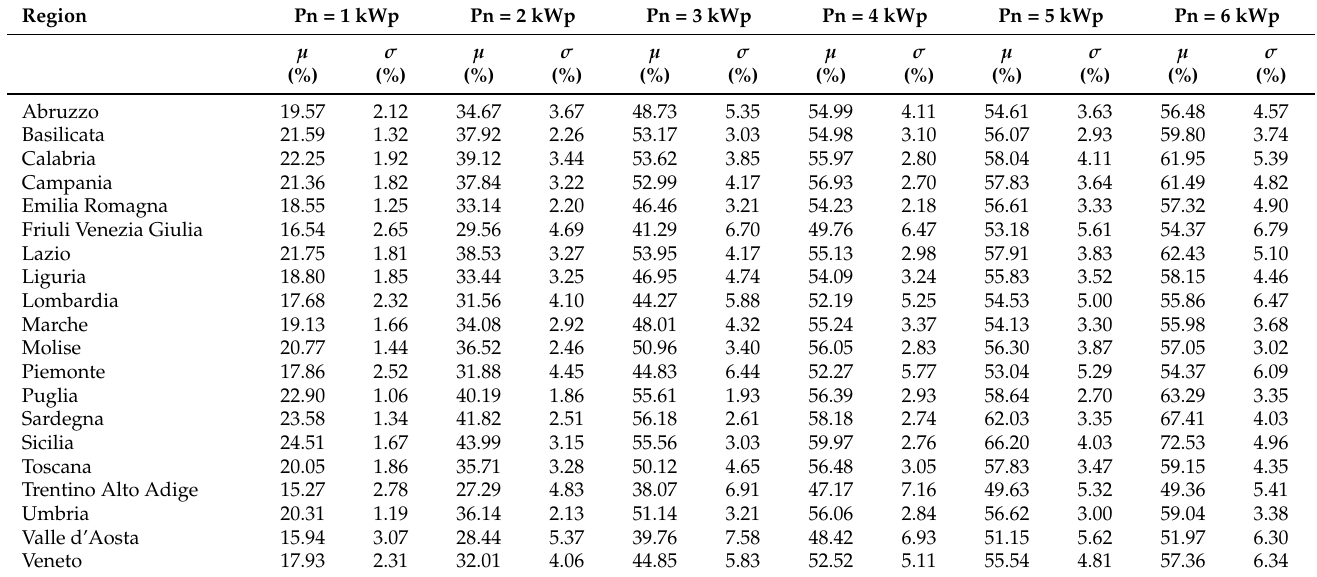
Table 21. Cost saving for E L = 4000 kWh without battery.